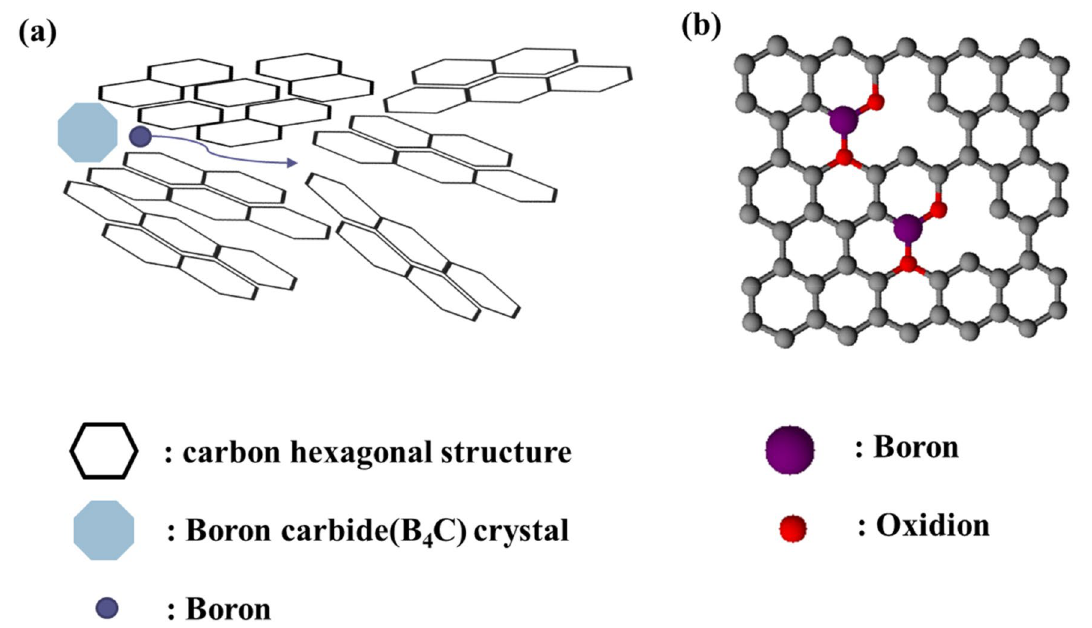
Fig. 4 Mechanism of 4203-BX-2500; a boron transfer by crystalline B